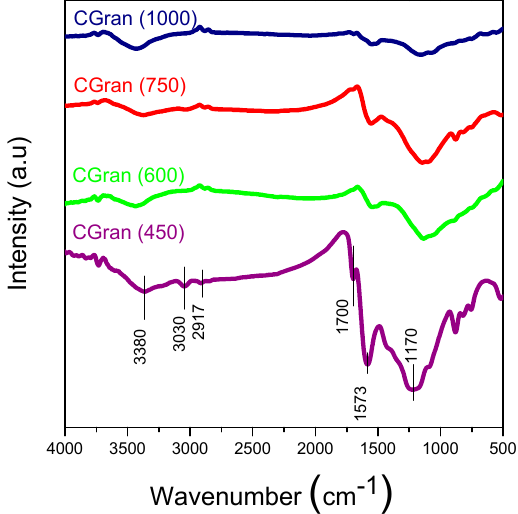
Figure 2. FT-IR of CGran(x) activated carbon supports.